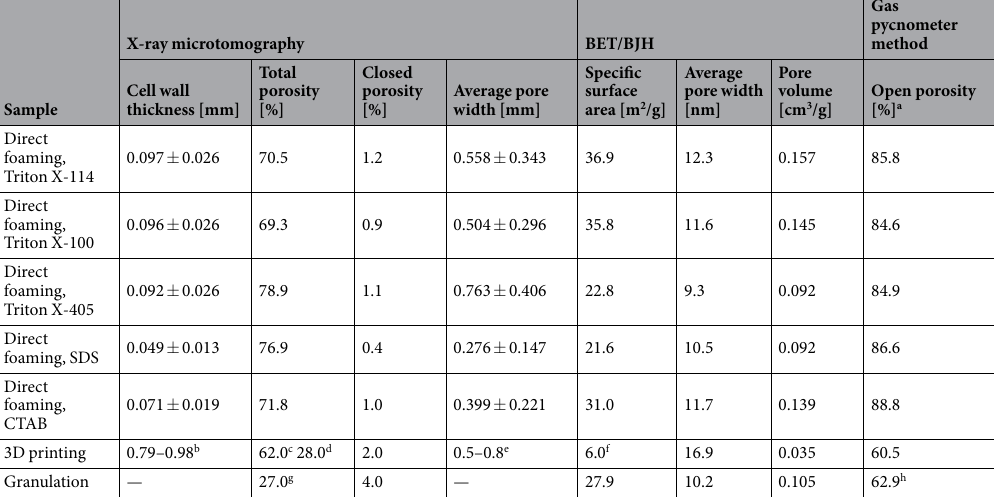
Table 1. Pore structure, Brunauer-Emmett-Teller (BET)-specific surface area, Barrett-Joyner-Halenda (BJH) pore size, and volume of the different filter materials. Note that microtomography is able to detect pore sizes > ∼ 10 µ m, while the BET/BJH method is able to detect pore sizes < 300 nm. Cell wall thickness and average pore width are reported with ± standard deviation. SDS = sodium dodecyl sulfate; CTAB = cetyltrimethylammonium bromide; a = open porosity ≈ total porosity; b = filament thickness; c = porosity in upper layers; d = porosity in the first layers; e = diameter of openings between filaments; f = specific surface area was measured after washing with hot, deionized water (before washing, specific surface